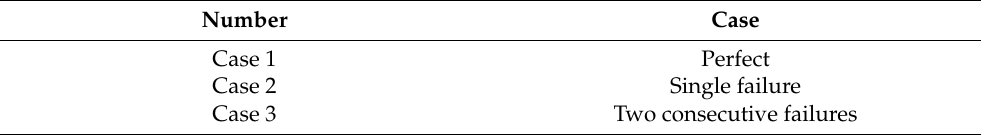
Table 2. Fastener failure